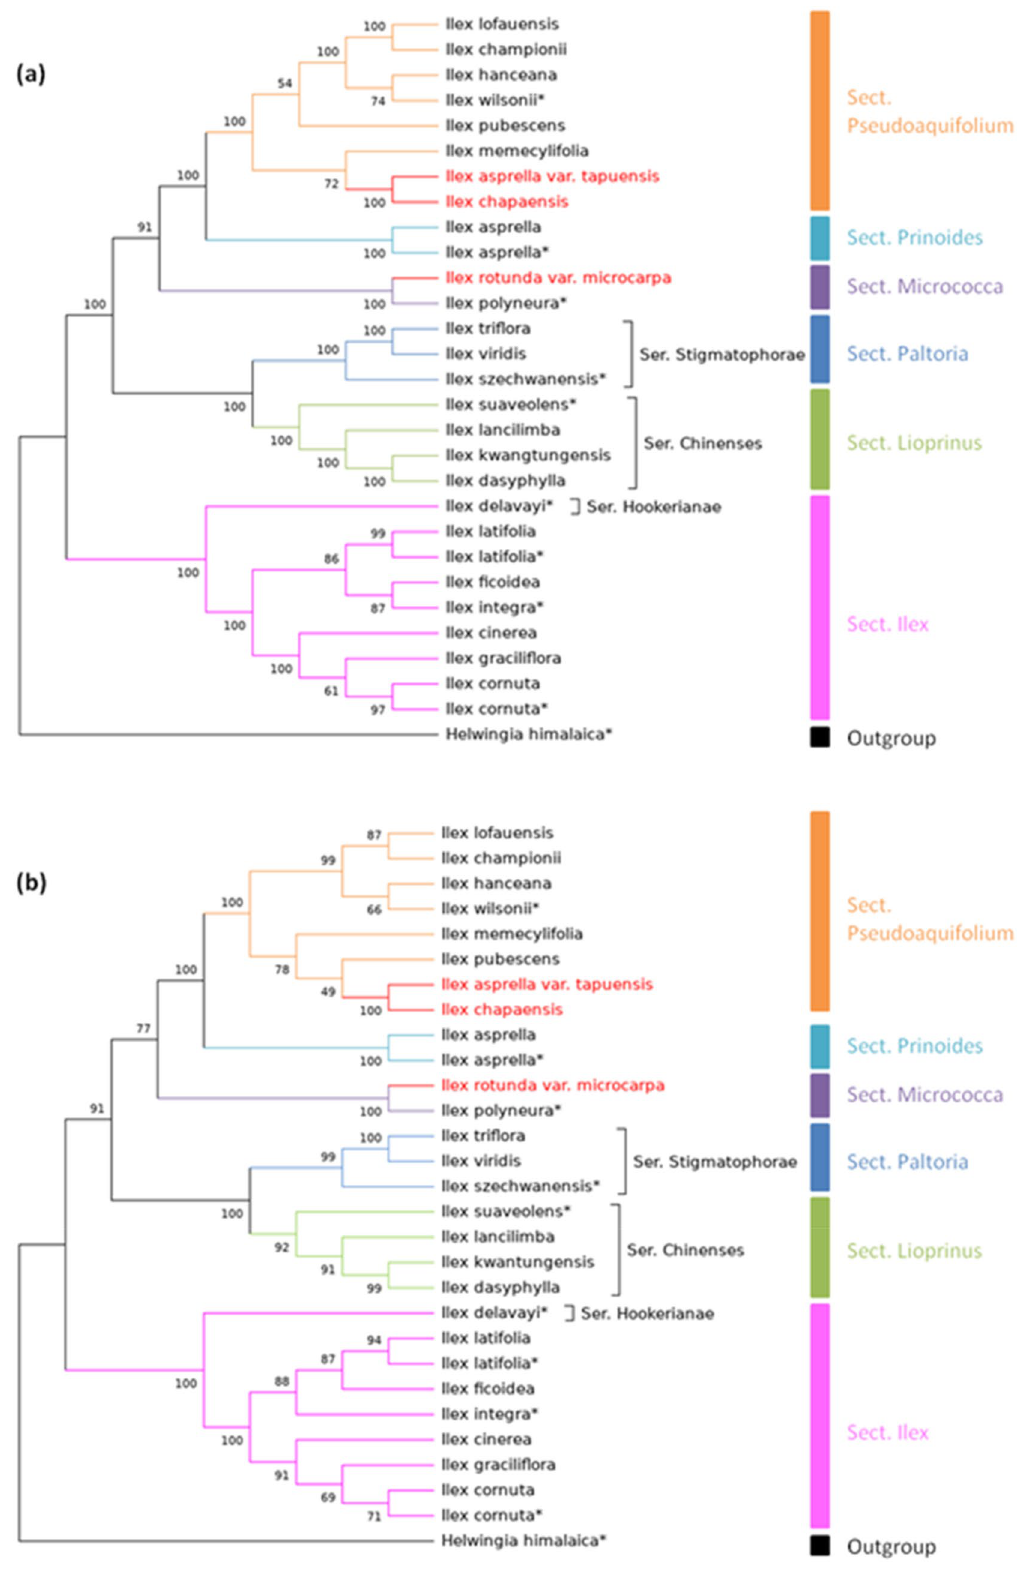
Figure 6. Phylogenetic tree of the Ilex species constructed via maximum likelihood (ML) with 1000 bootstraps by using (a) whole chloroplast genomes and (b) SSC regions. The numbers above indicate the corresponding bootstrap values, and the corresponding sections and series are labelled according to Flora of China and Flora Reipublicae Popularis Sinicae , respectively . Genomes obtained from previous research are marked with asterisks, while unexpected species classifications are labelled in